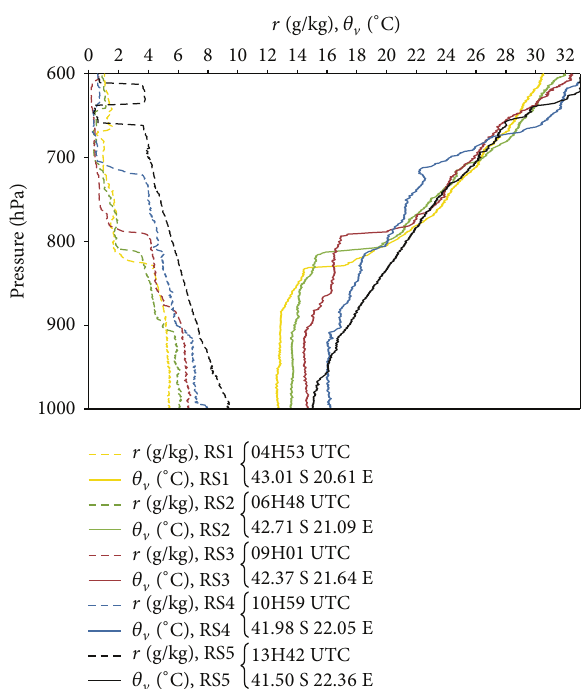
Figure5:Radiosoundingverticalprofilesofmixingratioandvirtual temperature as well as time and location releases.